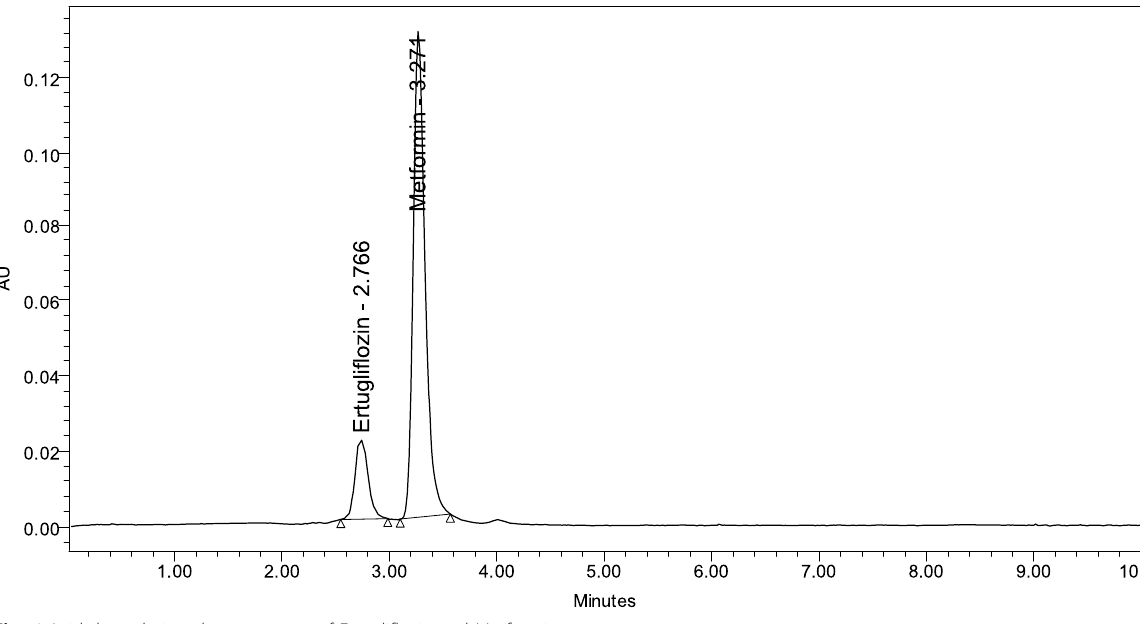
Fig. 6 Acid degradation chromatogram of Ertugliflozin and Metformin